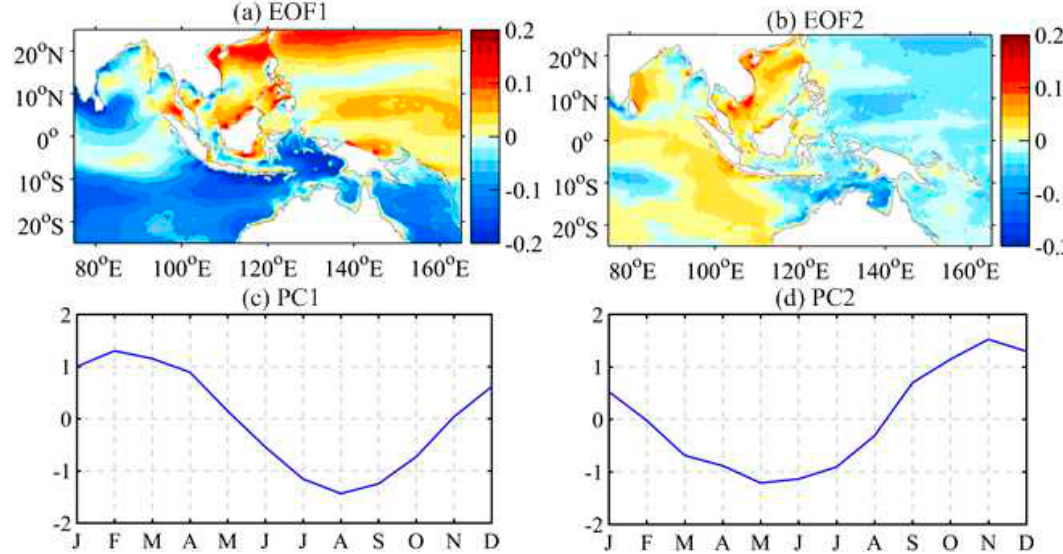
Figure 2. Seasonal NPP variability characterized by the first two EOF modes: ( a , b ) are the EOF spatial patterns (Unit: log10, mg C/m 2 /month); ( c , d ) are the time series of normalized principal components (PC).